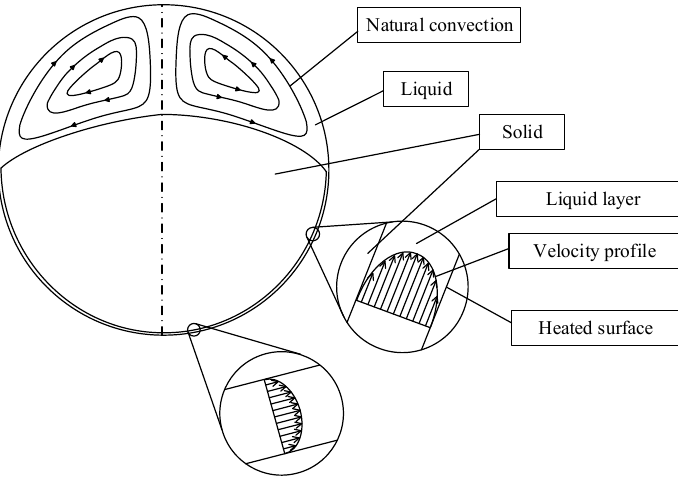
Figure 8. Liquid flow in the close contact melting in a sphere.